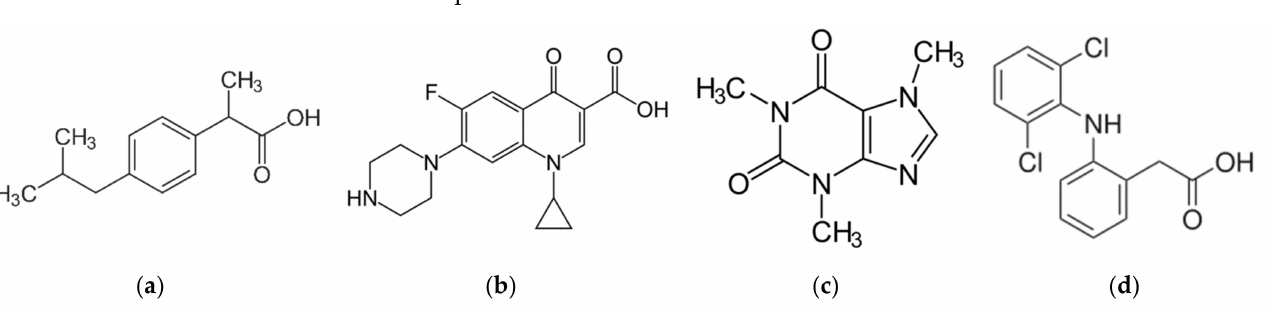
Figure 6. Chemical structures of ( a ) ibuprofen ( b ) CIP; ( c ) caffeine; ( d )